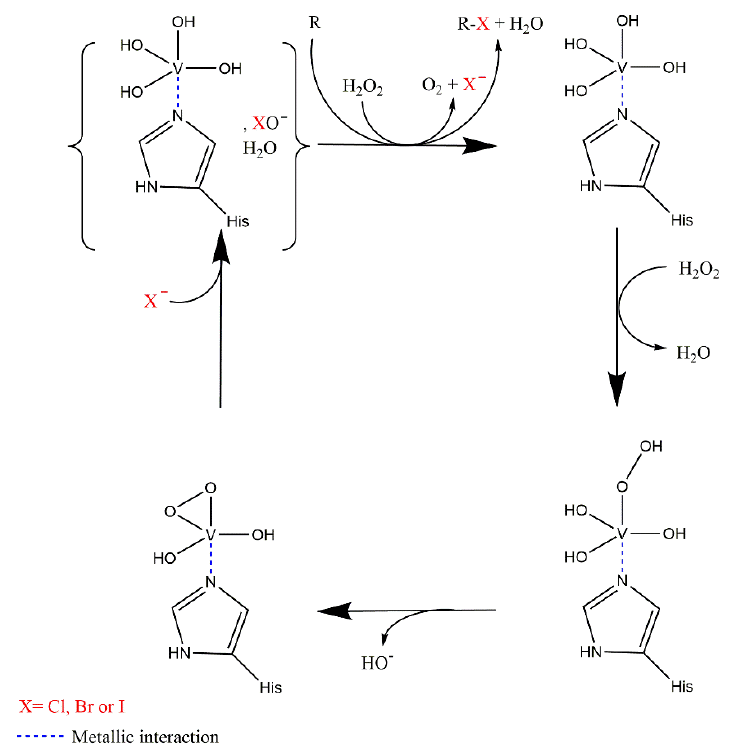
Figure 8. General halogenation mechanism of vanadium-dependent haloperoxidases inspired by [88]. Like hHPOs, vHPOs present a lack of selectivity during the halogenation